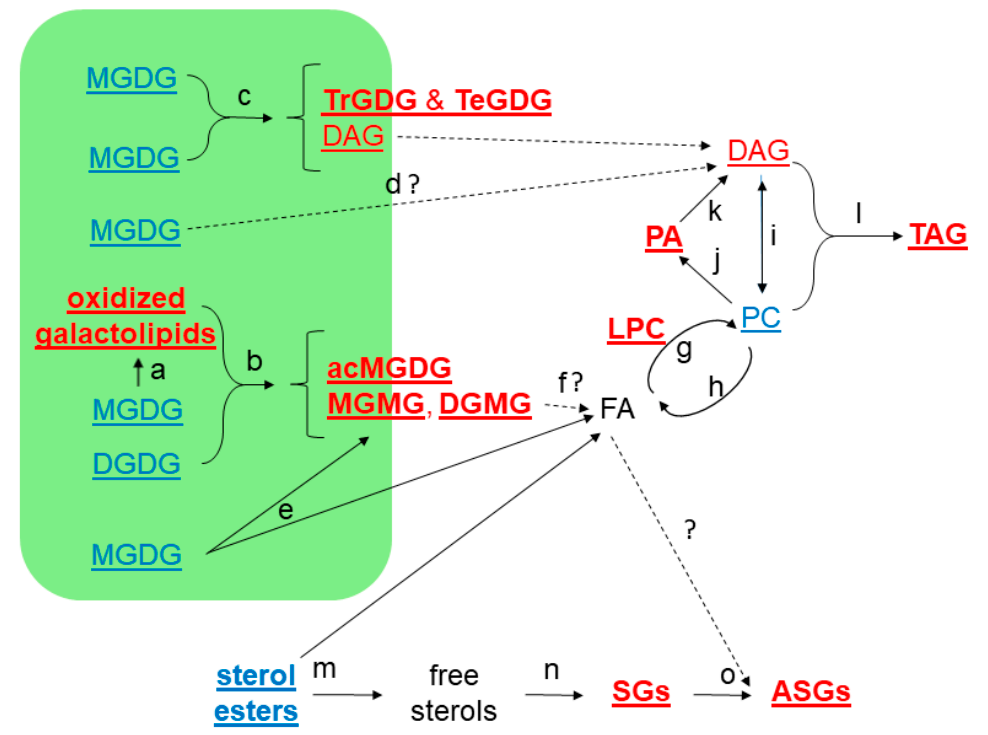
Figure 10. Lipid metabolic pathways involved in heat stress response in Arabidopsis leaves. Lipid groups in bold type were altered significantly under the moderate heat stress conditions of Path 2 of the main experiment (Figure 2). Lipid groups underlined were changed under severe stress (Figure 9). The green area represents the chloroplast and its lipids. Lipid groups in red type are increased, those in blue are decreased, and those in black were not measured. The letters “a” to “o” indicate reactions. Dashed lines indicate processes that are less well understood, or less clearly involved in producing the observed lipid changes, in comparison to the solid lines. “a”: Reactions involved in oxidation of galactolipids. The most well-characterized process involves formation of OPDA (or dnOPDA) through a lipoxygenase, allene oxide synthase, allene oxide cyclase, and oxophytodienic acid reductase. This conversion of 18:3 to OPDA (or 16:3 to dnOPDA) was demonstrated to occur while the fatty acid is esterified to the galactolipid [26]. The processes forming other oxidized galactolipids during heat stress in Arabidopsis leaves are less well-characterized, but they are likely to include the non-enzymatic formation of phytoprostanes [57], as well as other enzymatic pathways. “b”: Acylation of MGDG on the 6-position of the galactose ring with a fatty acid coming from DGDG or a second MGDG, catalyzed by AGAP1 [24]. “c”: Processive galactosylation of MGDG, catalyzed by the galactolipid galactosyltransferase SFR2, to form polygalactolipids, such as TrGDG and TeGDG, and DAG [29,30]. “d”: Possible formation of DAG from galactolipids by an unknown lipase. This pathway could contribute 16:3 as 18:3 / 16:3 DAG to the PA, PC, and TAG pools. “e”: Fatty acids can be hydrolyzed